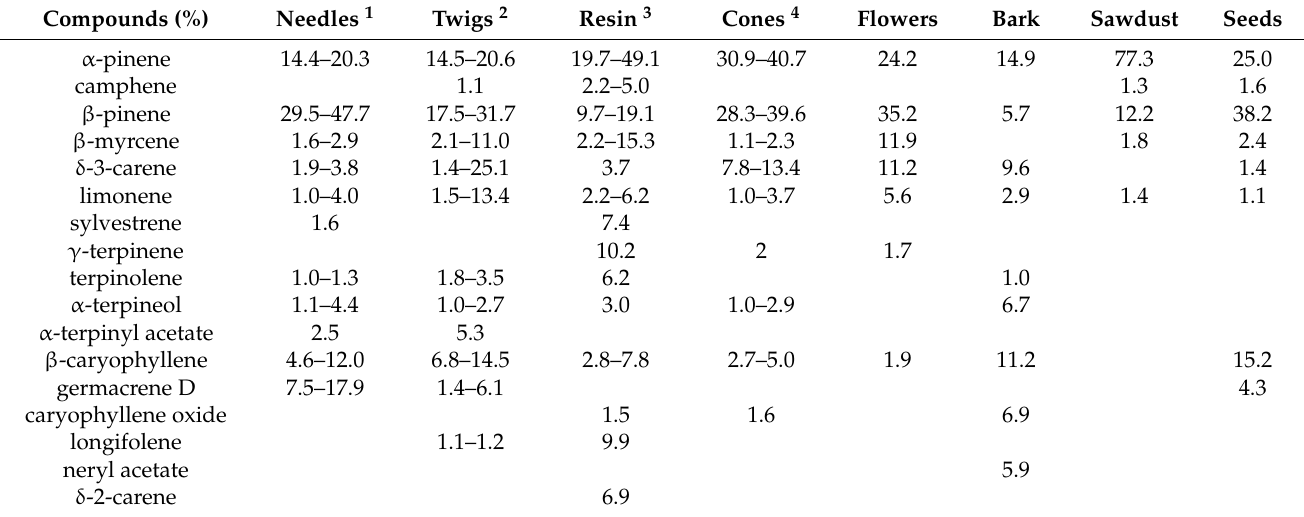
Table 1. Essential oil composition ( ≥ 1%) reported for Pinus brutia needles, twigs, resin, cones, flowers, bark, sawdust and seeds.